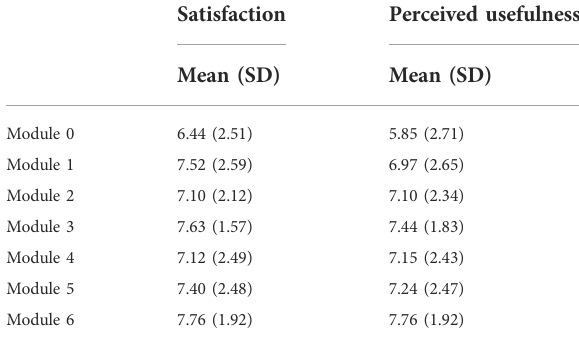
TABLE 6 Satisfaction with the intervention modules and their perceived